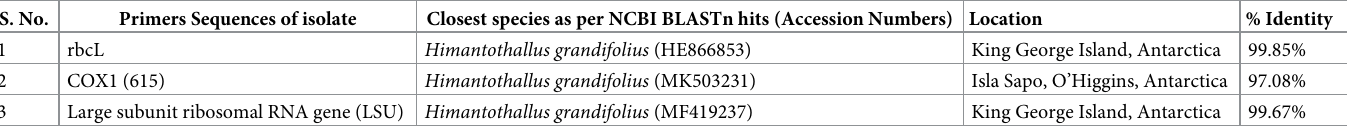
Table 1. Top BLASTn hits of the macroalgal sequence. S.